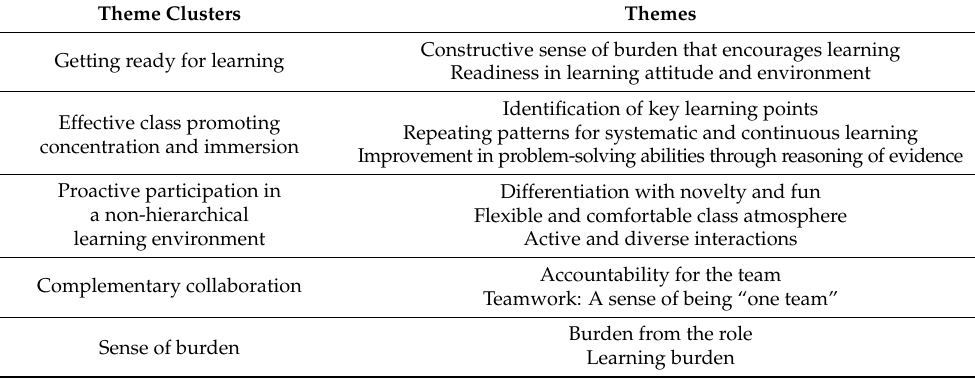
Table 4. Themes and theme